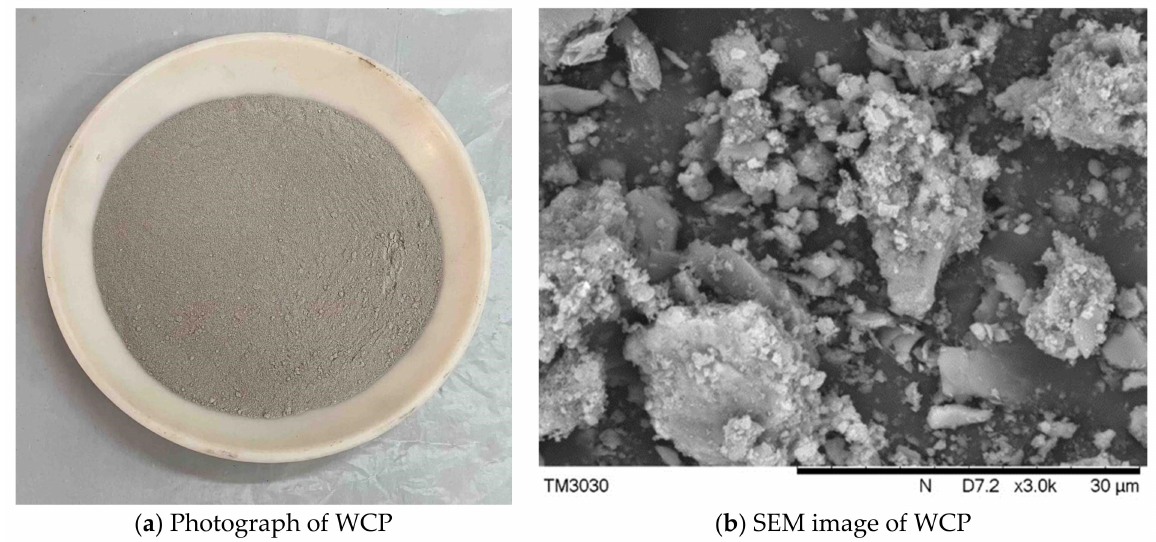
Figure 2. Photograph and SEM image of WCP.